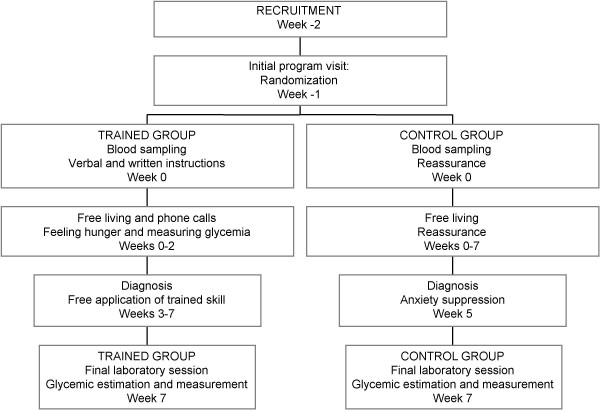
Investigation design. A randomized and controlled 7-week pilot clinical investigation to study the acquisition of the capacity to estimate blood glucose by body feelings after adequate training.